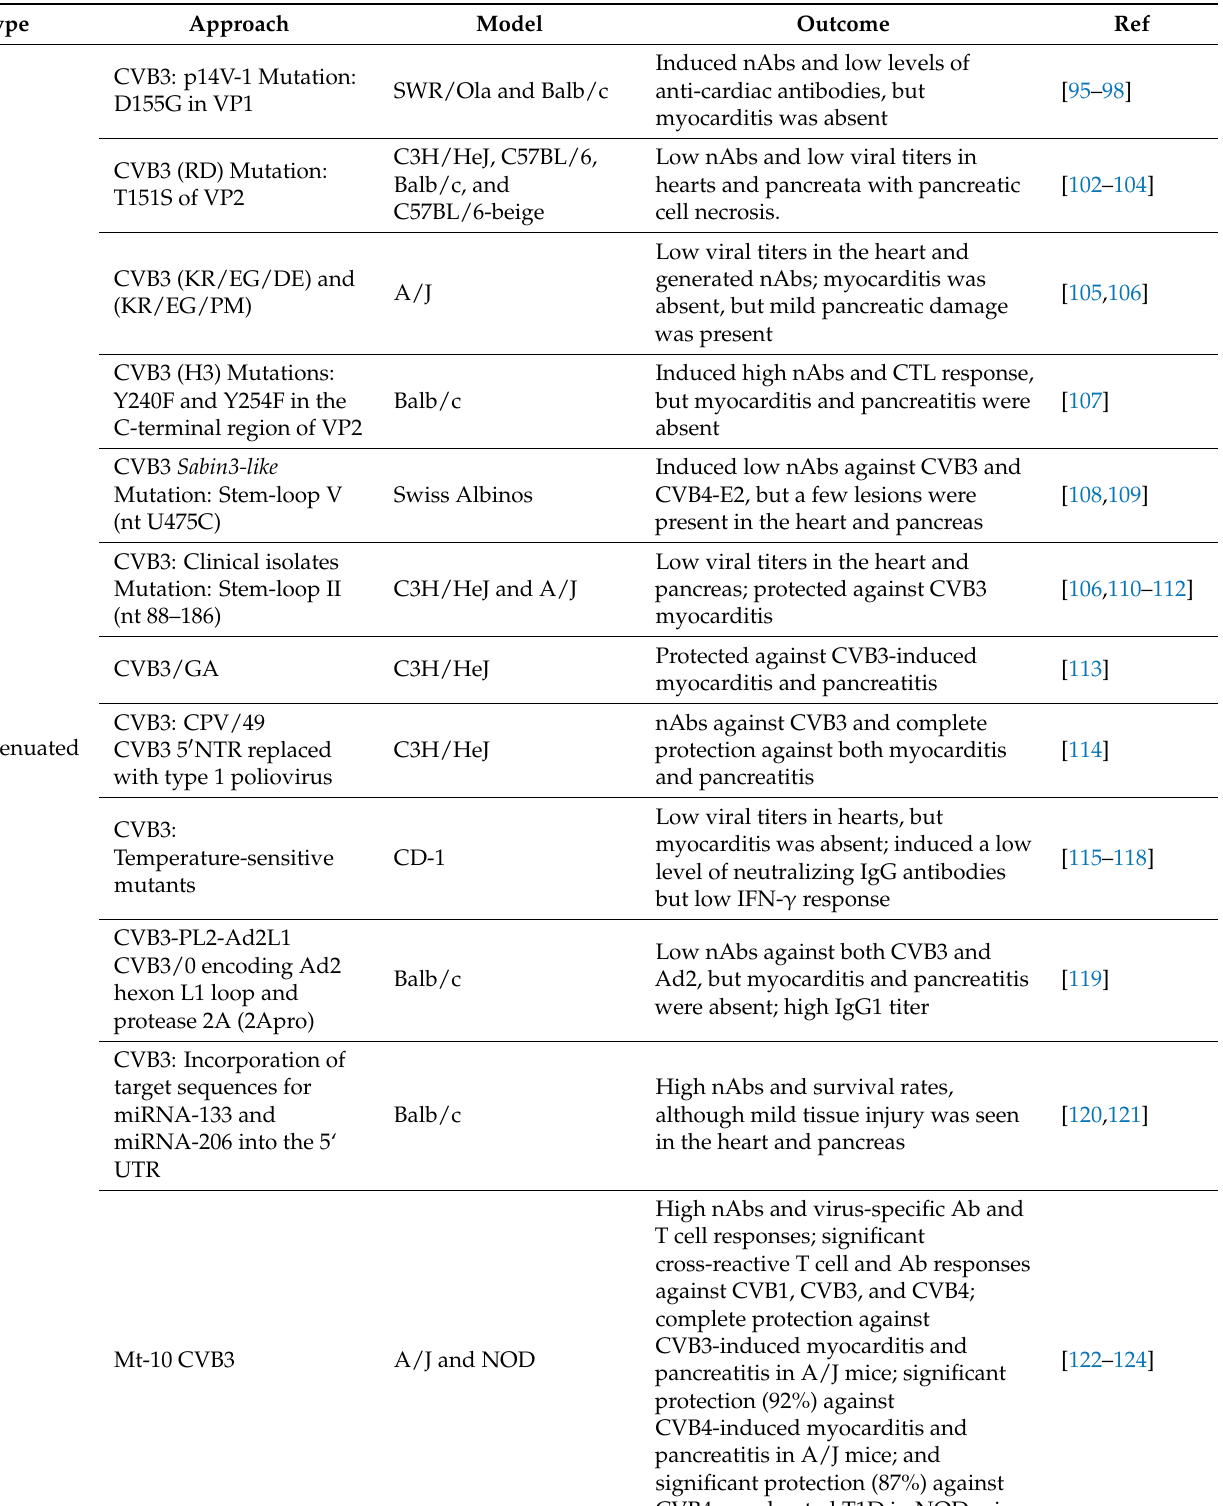
Table 1. Efficacy of vaccines used for various CVB